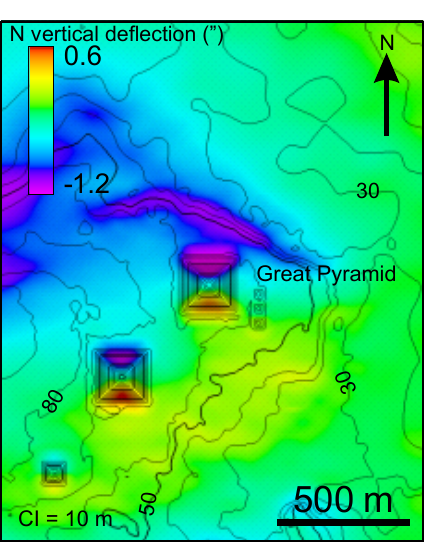
Figure 3. Calculated northward deflection of the vertical (colours) with topographic contours (black) around the pyramids. The high- est calculated deflections are on the northern and southern flanks for the bigger two pyramids, though the northern edge of the Giza Plateau also has a strong southerly deflection of the vertical. Densi- ties assumed are 2000kgm − 3 for the pyramid and 2200kgm − 3 for the topography. Topographic contour interval